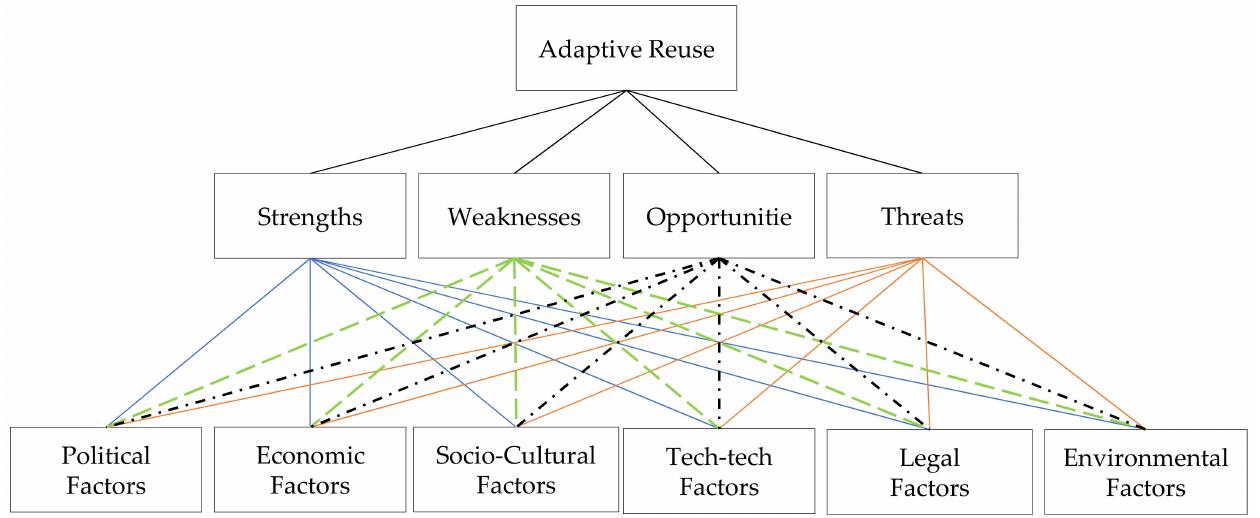
Figure 2. Adaptive reuse assessment hierarchical model.